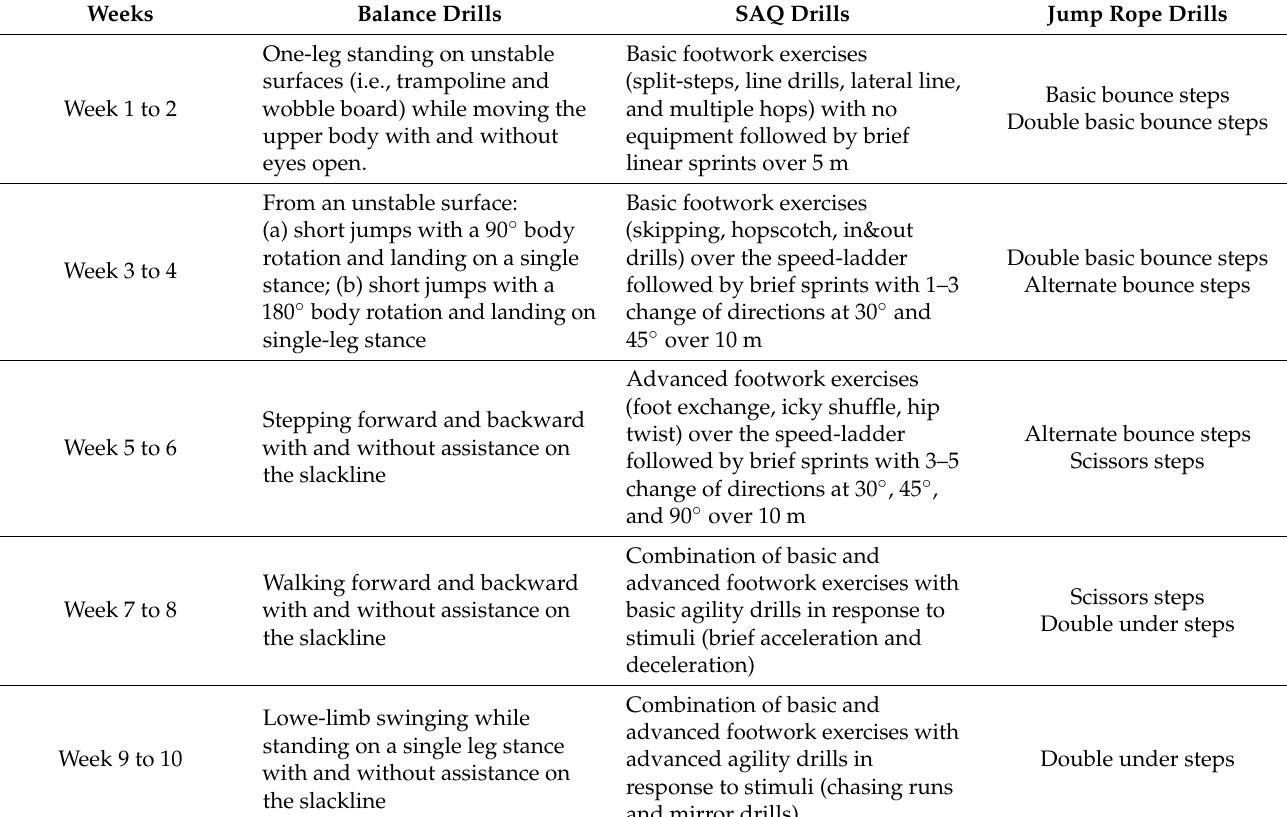
Table 1. Training content of the 10-week intervention performed by the